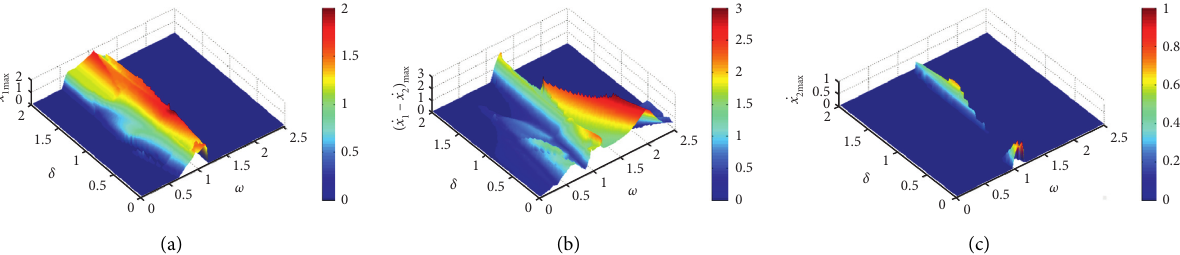
Figure 18: Three-dimensional surface diagrams of the maximum impact velocity of the system associated with each constraint when � δ � 1 . 5. (a) Constraint A δ 1 ; (b) constraint A 12 ; (c) constraint A 2 1 2